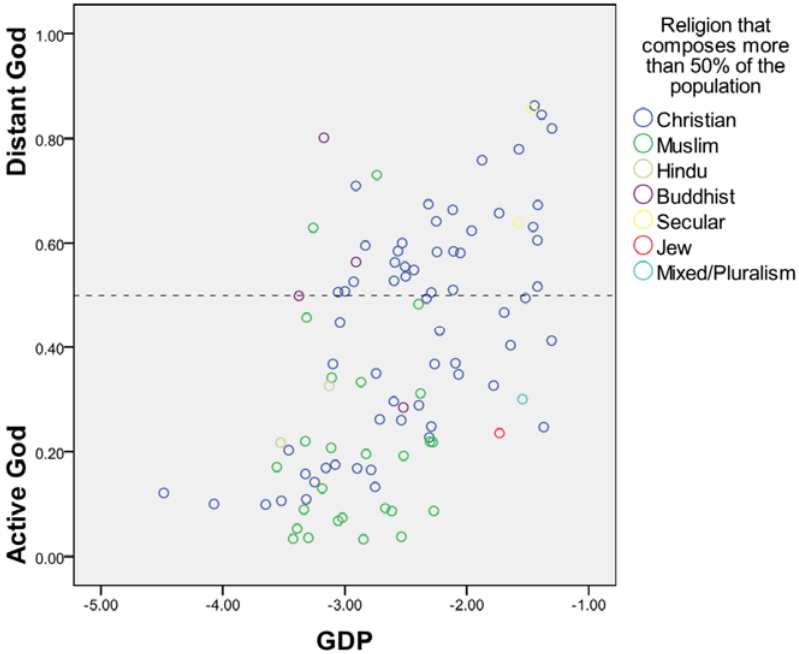
Figure 2. God around the World (correlated with per capita